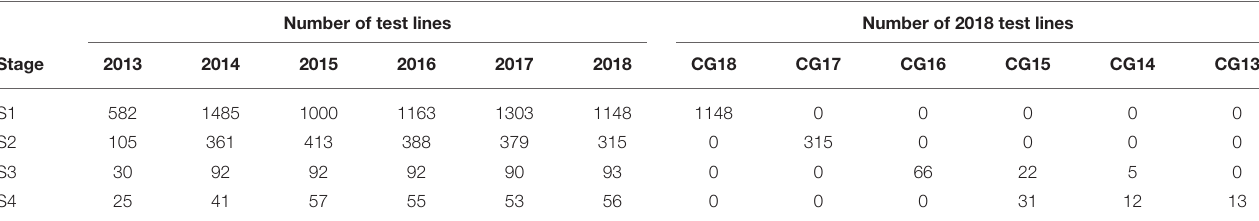
TABLE 5 | Number of test lines in each stage (S1 to S4) and year (2013-2018) in the durum breeding program. Number of test lines Number of 2018 test